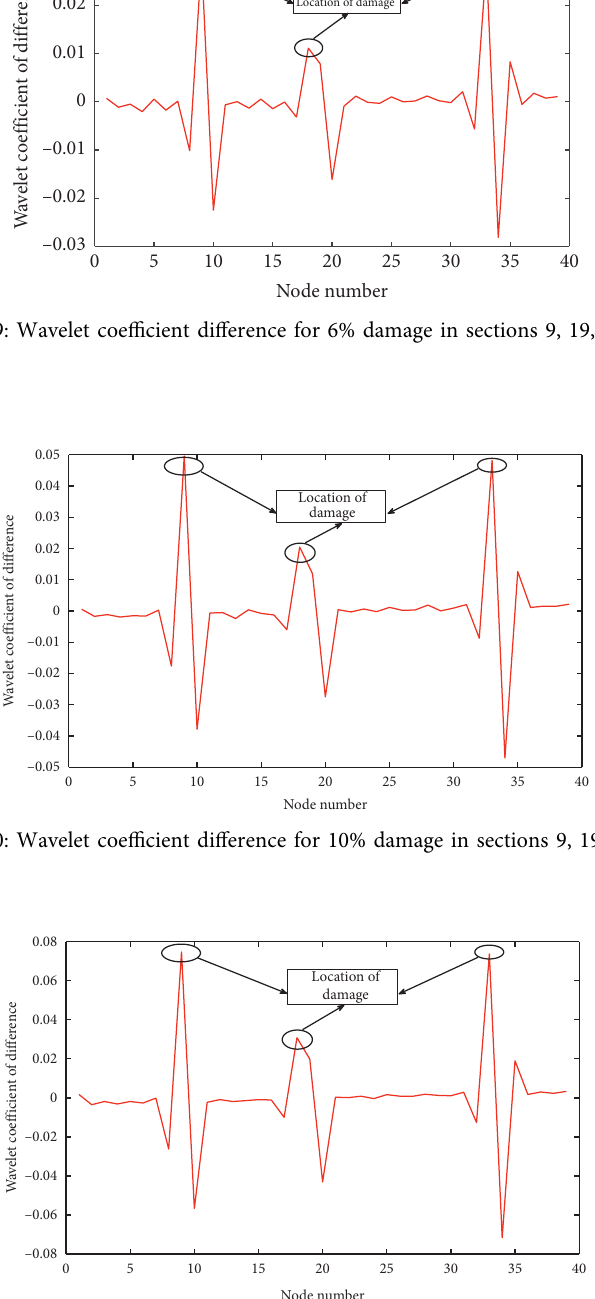
Figure 11: Wavelet coefficient difference for 15% damage in sections 9, 19, and